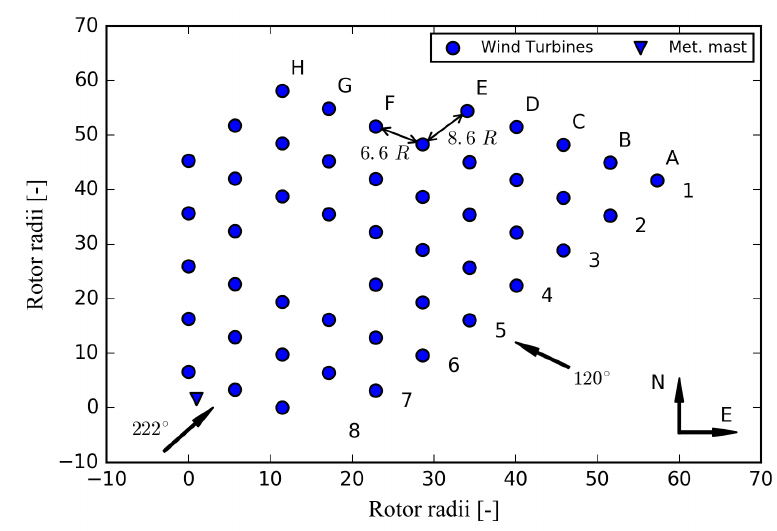
Figure 4. Layout of Lillgrund wind farm, where R is the rotor radius. 120 ◦ and 222 ◦ are the inflow directions to be investigated.